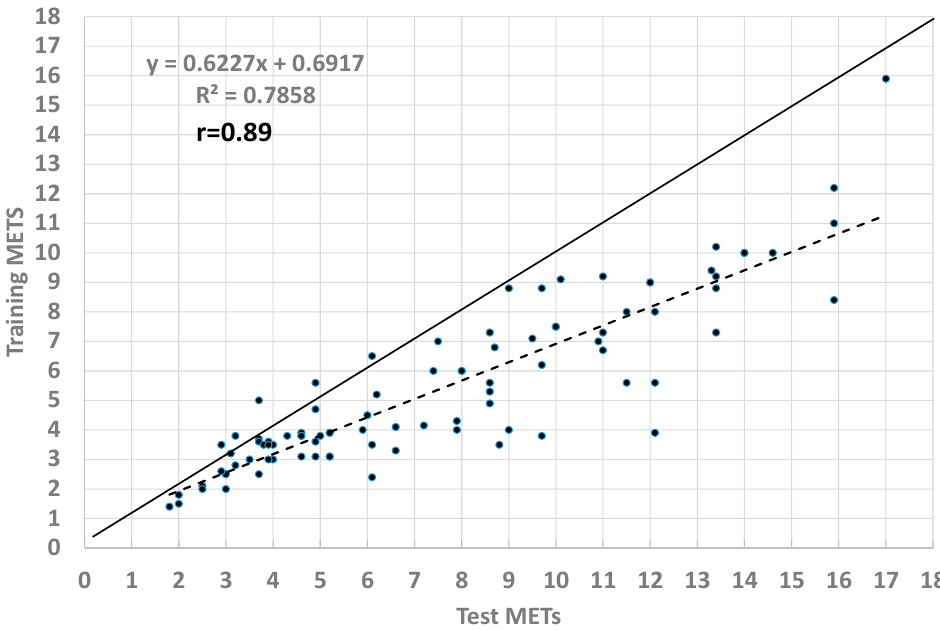
Figure 1. Comparison of exercise intensity (expressed as Metabolic Equivalent Task (METs) during exercise testing and exercise training with the same level of objective exercise intensity (% of Heart Rate Reserve, Rating of Perceived Exertion, Talk Test) based on combined results from several studies